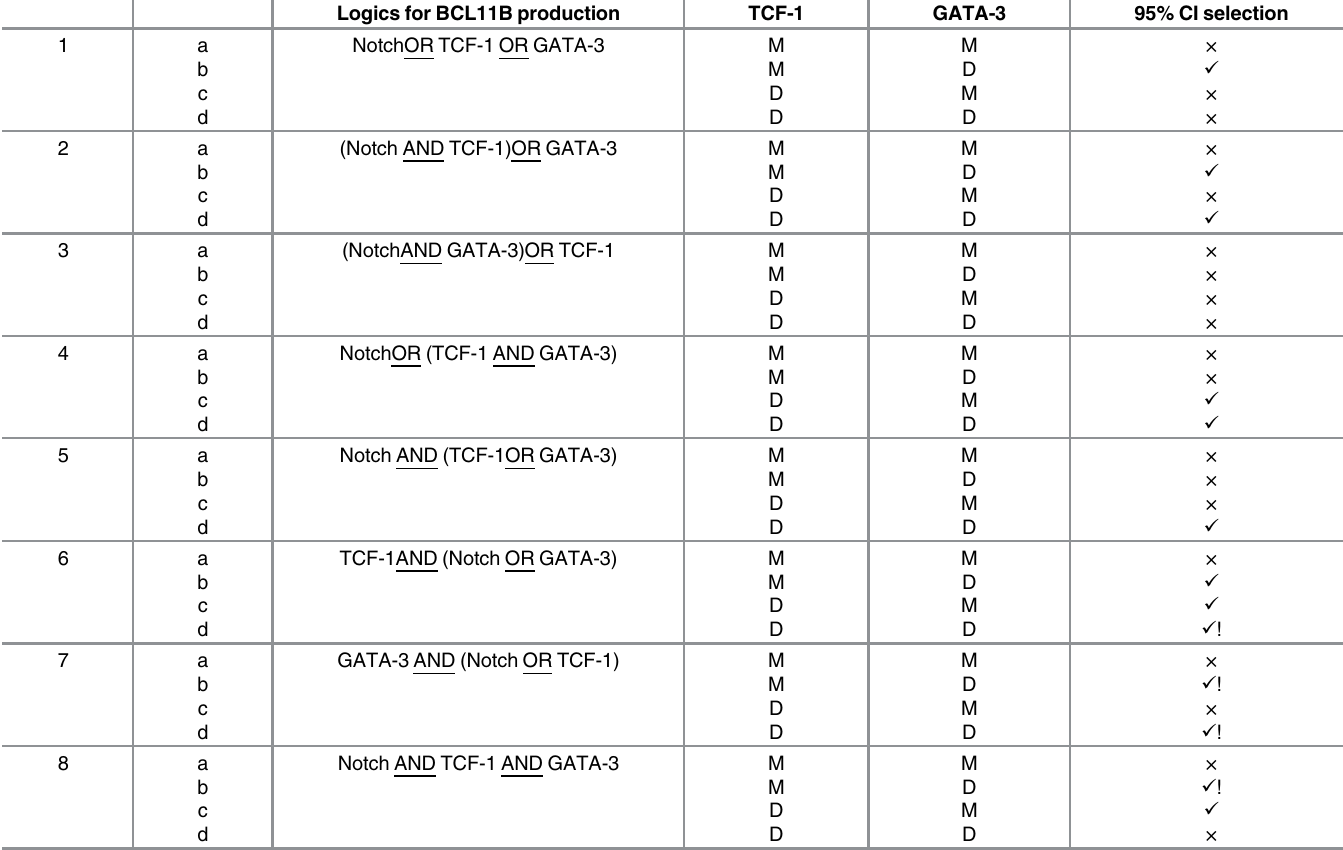
Table 1. Model predictions for the different combinatorial configurations for BCL11B production after the selection based on the 95% confidence interval (CI) and plausible values for the half-lives. For each of the 8 interaction variants, Eqs 3-10 (S1 File), all combinations of the Hill coefficients of TCF-1 and GATA-3 ( i.e . n T , B and n G , B ) were considered: (M,M); (M,D); (D,M); and (D,D) where M denotes monomer (Hill coefficient equals to 1) and D for dimer (Hill coefficient equals to 2). Notation: × indicates failure and ✓ success with regard to the CI 95% selection and ✓ ! those configurations that also give rise to reasonable values for the